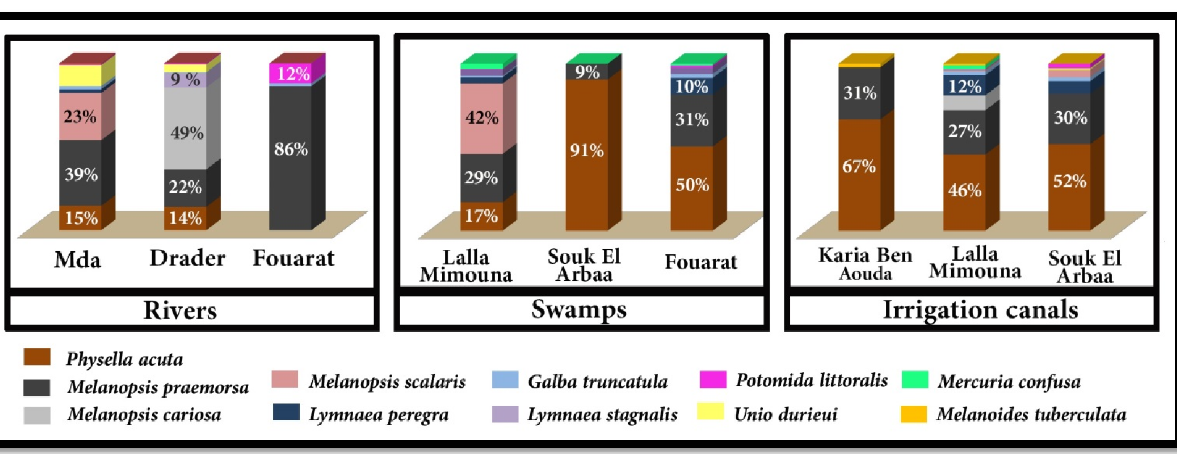
Figure 4. Relative abundance of species harvested by area prospected in the Gharb region (Morocco) from May 2012 to May 2013.